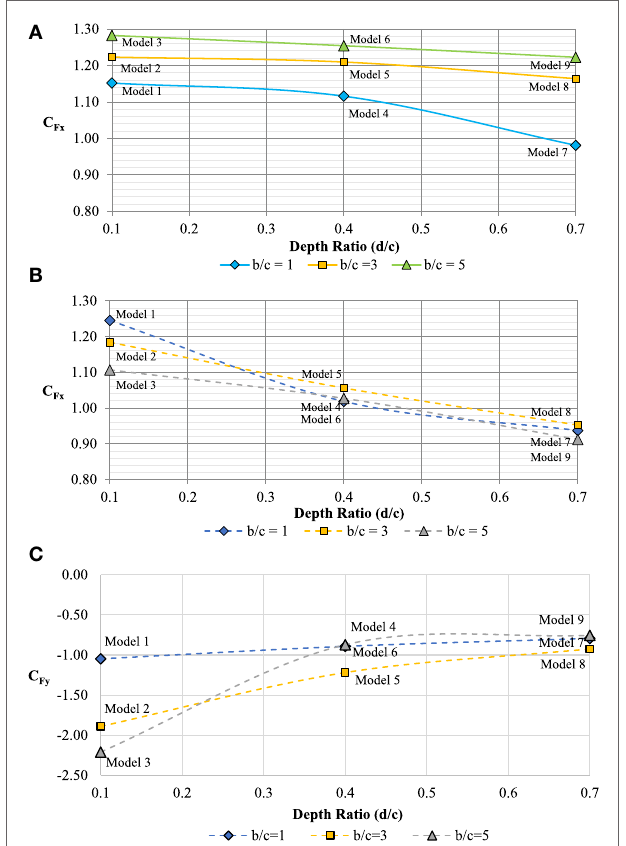
FIGURE 6 | Effect of depth ratio on: (A) C Fx for 0°; (B) C Fx for 45°; (C) C Fy for 45°.